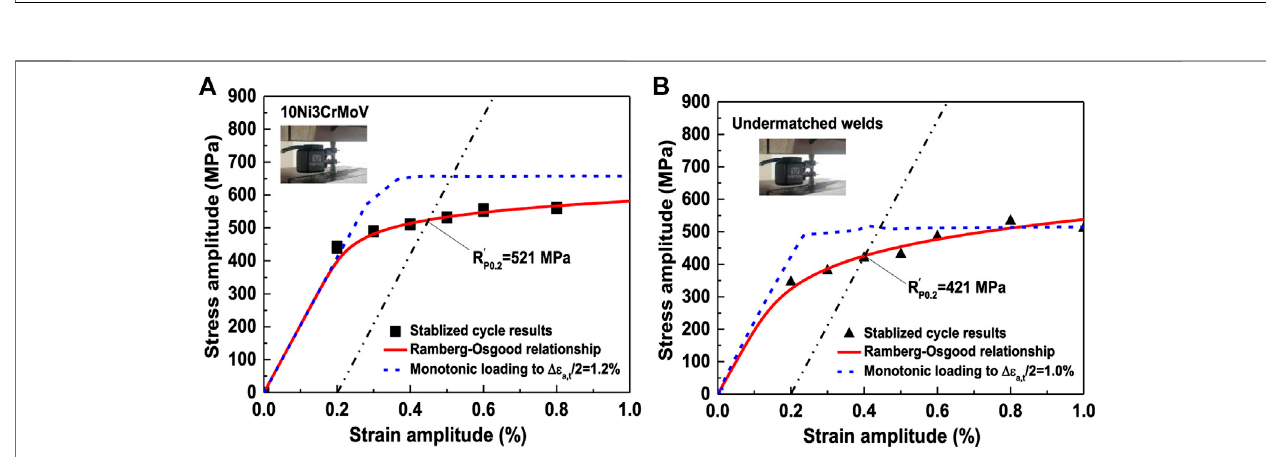
FIGURE 3 | Comparison between monotonic stress – strain curves and cyclic R – O relationship curves in the middle of fatigue life. (A) 10CrNi3MoV steel and (B) undermatched weldments.